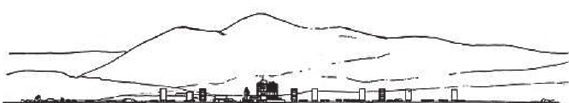
fig. 5. Skyline of Saint-Dié in the landscape showing the building of the first and second phases. from le Corbusier 1946, OEuevre Complete. 1938–1946, Zürich: Girsberger: